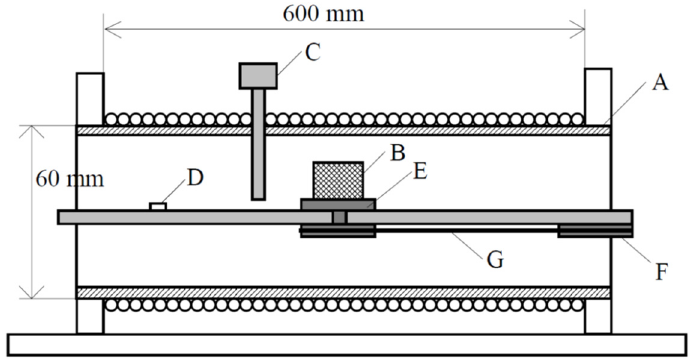
Figure 3. Solenoid for calibrating H sensing coils.